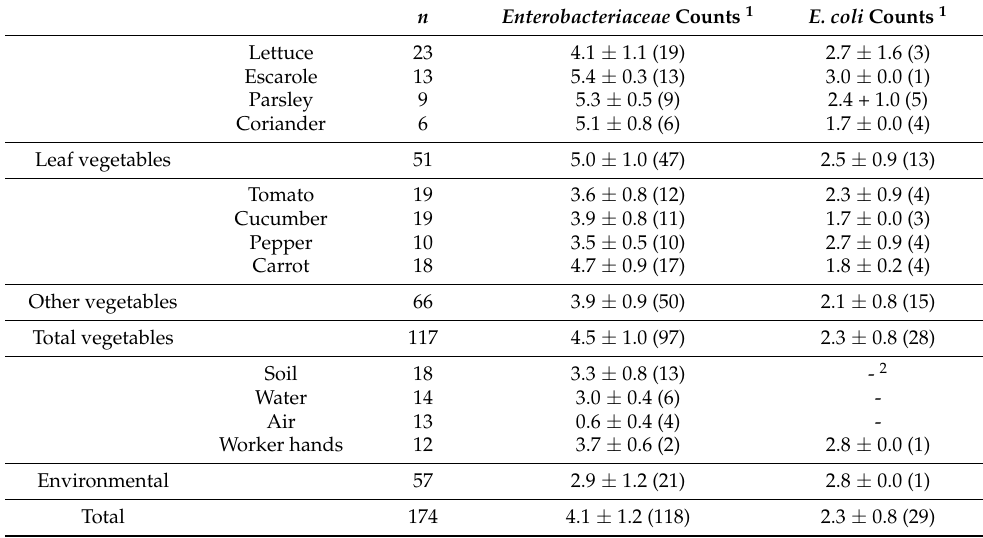
Table 1. Counts (log cfu/g or mL) of Enterobacteriaceae and E. coli in vegetables and environmental samples.